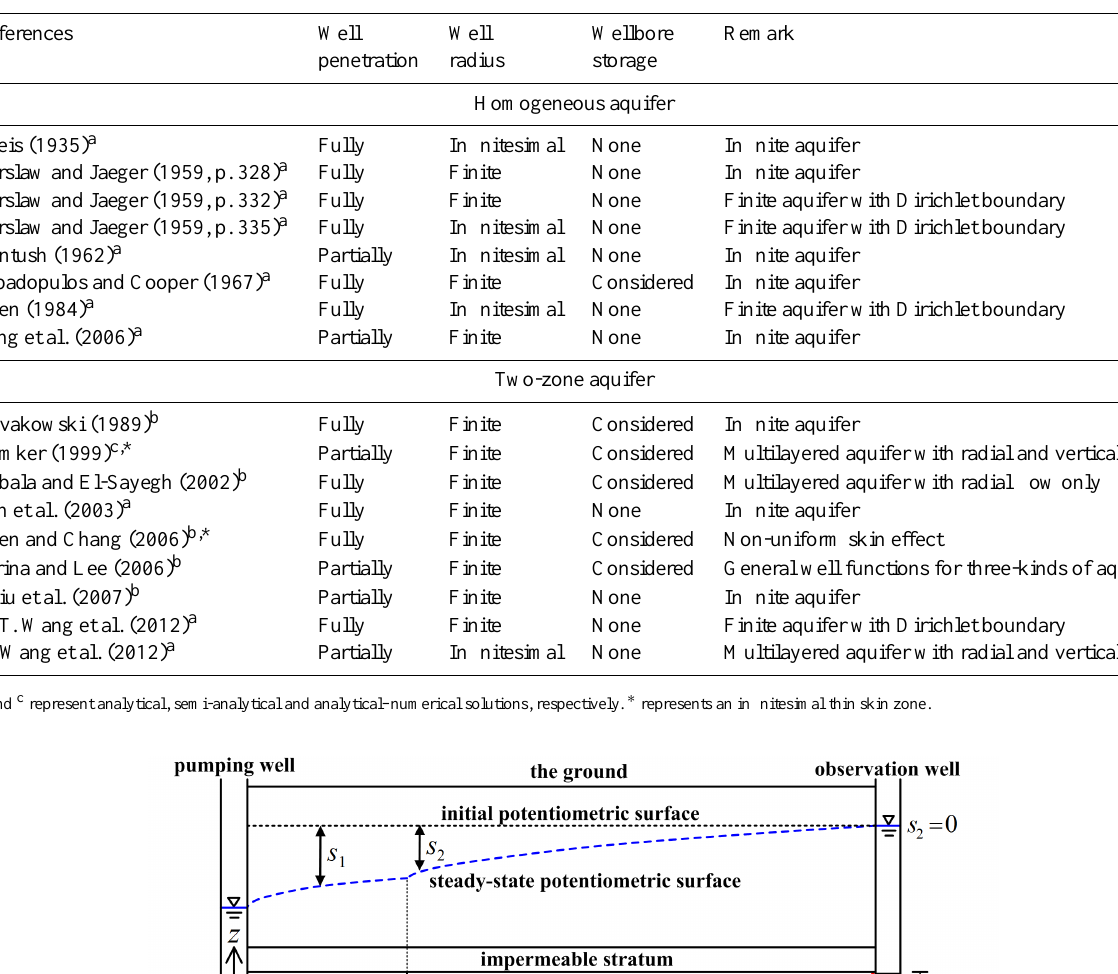
Table 1. Categorization of the solutions for the constant-flux pumping in confined aquifers.